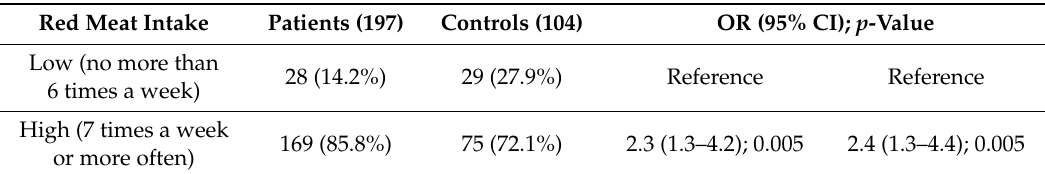
Table 1. Frequency of red meat intake in groups of patients and controls. OR, odds ratio; CI, confidence